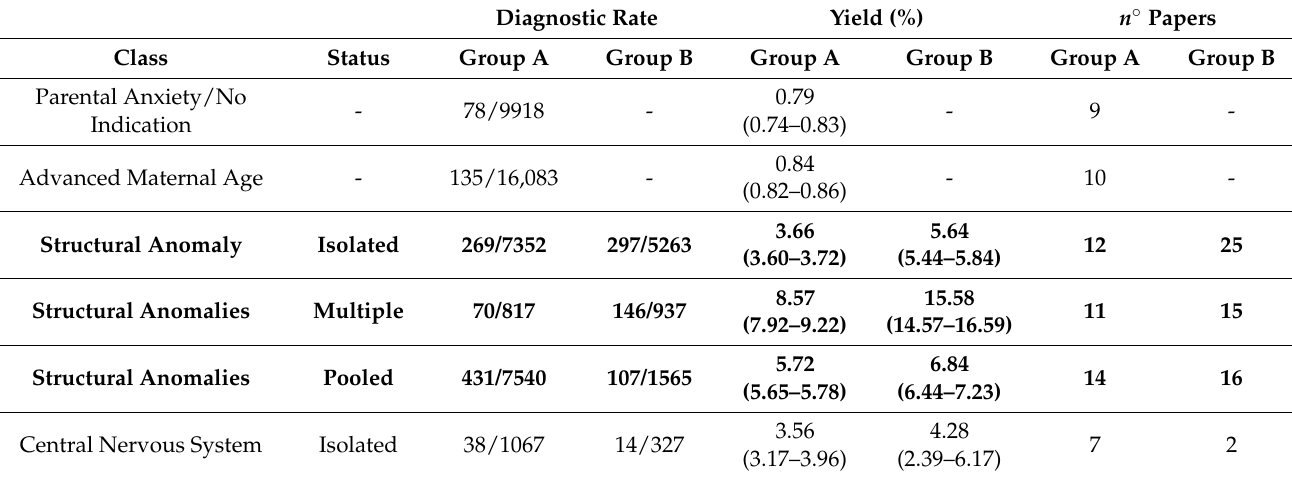
Table 1. CMA—Meta-analysis Group A and B. Diagnostic